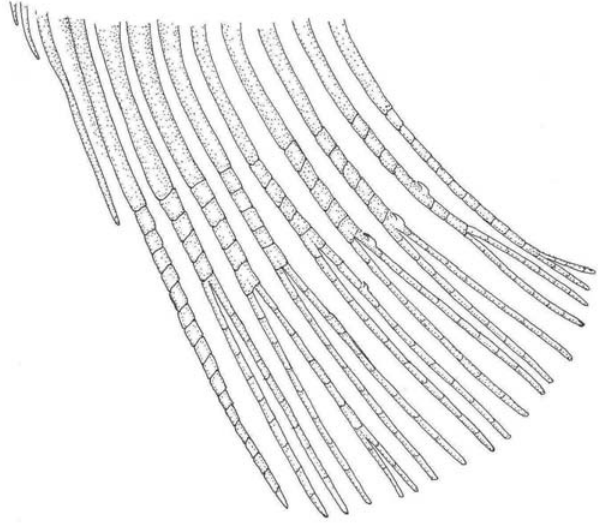
Fig. 50. Mimagoniates pulcher , developing male, MNRJ 4233, 37.0 mm SL; anterior 13 anal-fin rays, lateral view, left